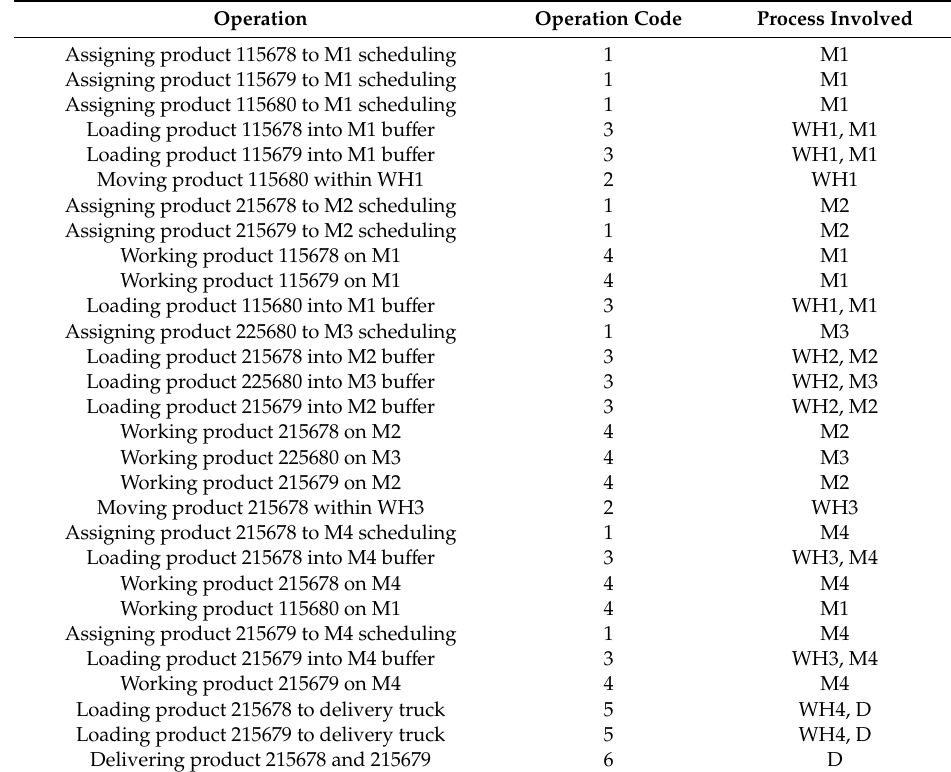
Table 5. Production operations of the undisturbed scenario.